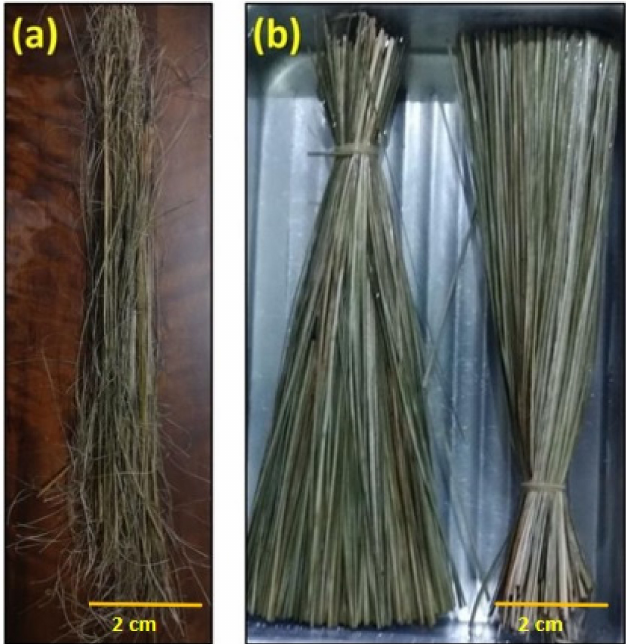
Figure 1. ( a ) Sedge fibers as received; ( b ) sedge fibers immersed in water for 24